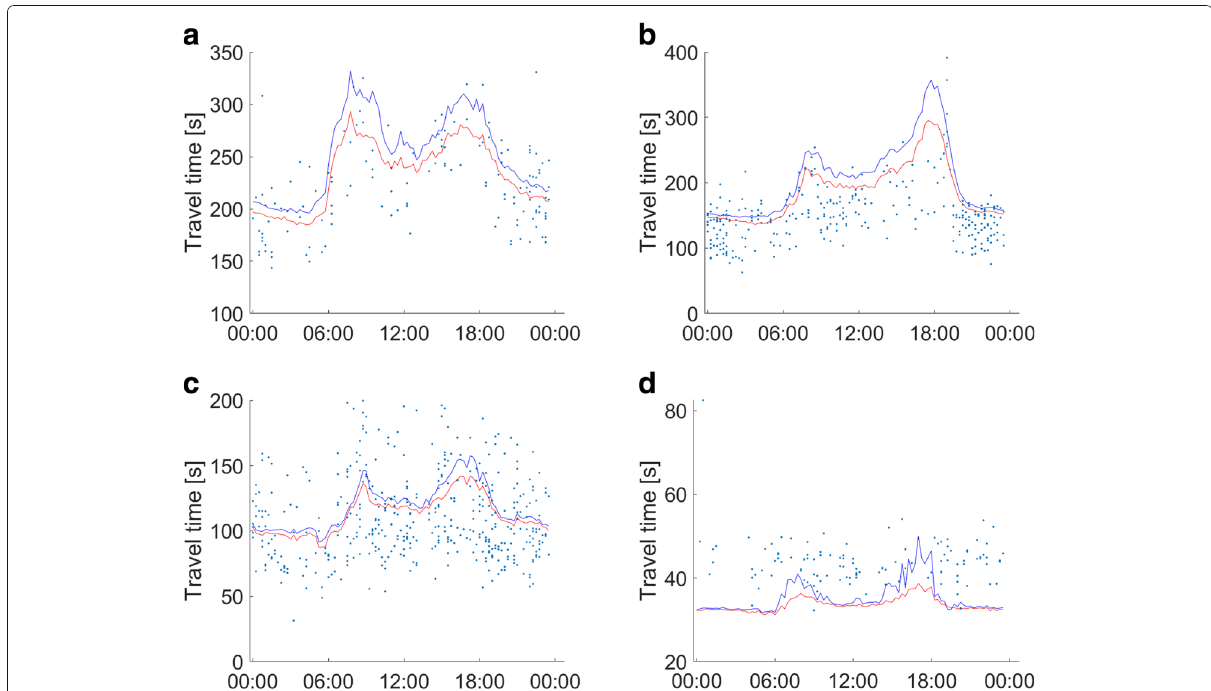
Fig. 8 Comparison of measured route travel times (in seconds) versus predicted (blue: direct, red: indirect method) for four routes. a Hietzing b WBH c Ring d